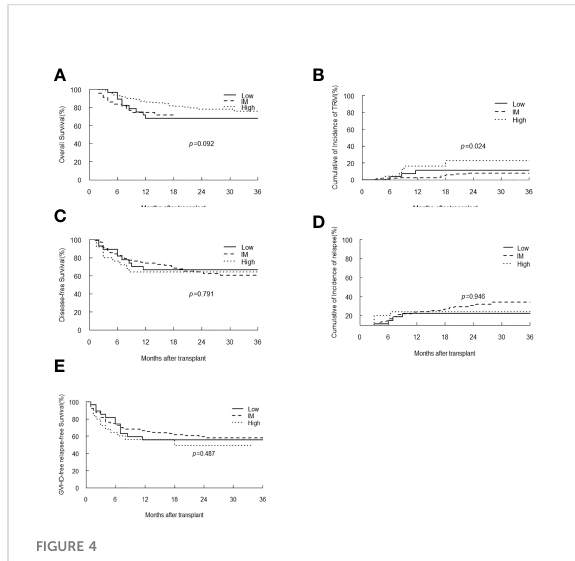
FIGURE 5 Overall survival (OS) (A) , transplant-related mortality (TRM) (B) , Disease-free survival (DFS) (C) and GVHD-free, relapse-free survival (D) of SAA patients strati fi ed by EBV-level.